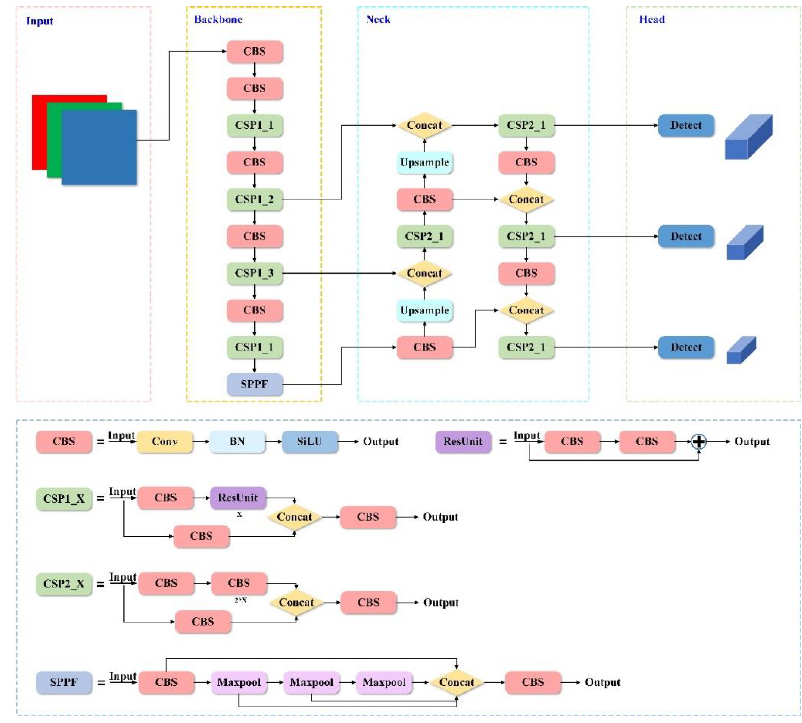
Figure 3. Structure of YOLOv5 network. Table 2. The abbreviations and corresponding full name in Figure 3.